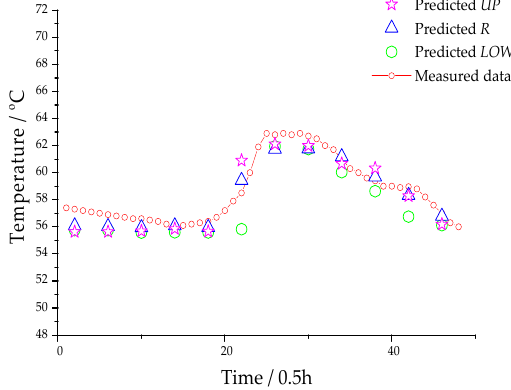
Figure 8. Comparison of predicted fluctuation range with the measured data.